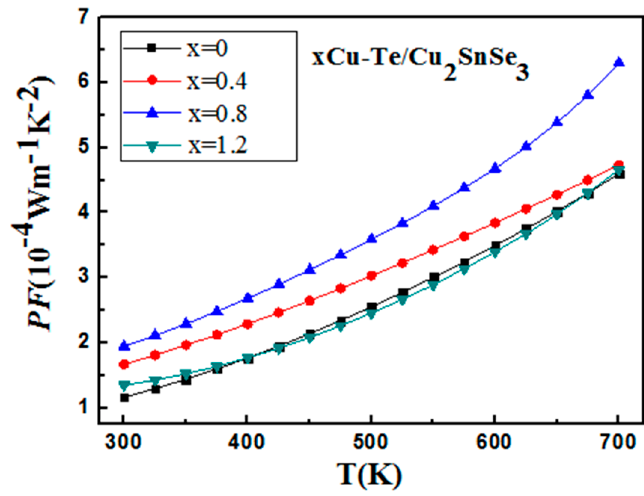
Figure 8. Temperature dependence of the power factor (PF) of Cu–Te/Cu 2 SnSe 3 composites.